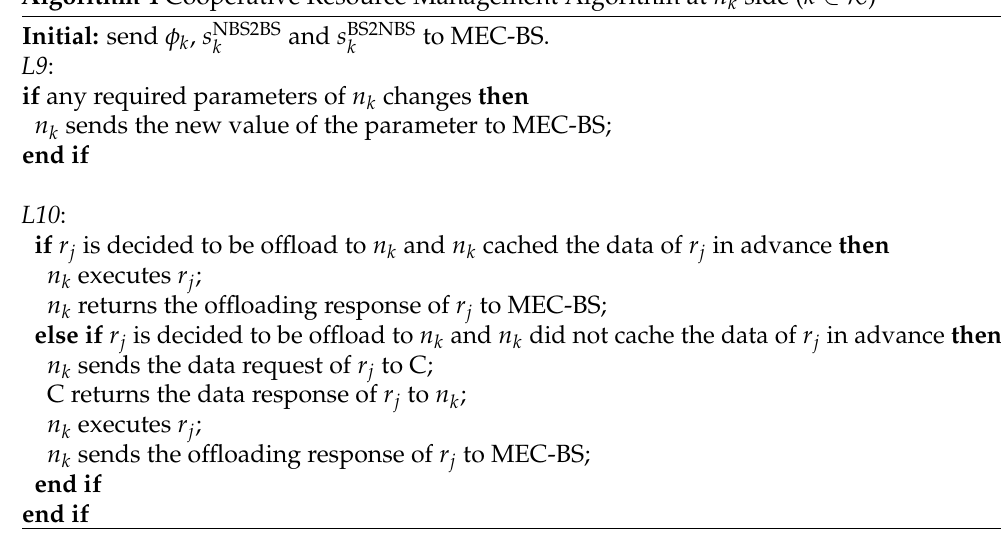
Algorithm 4 Cooperative Resource Management Algorithm at n k side ( k ∈ K